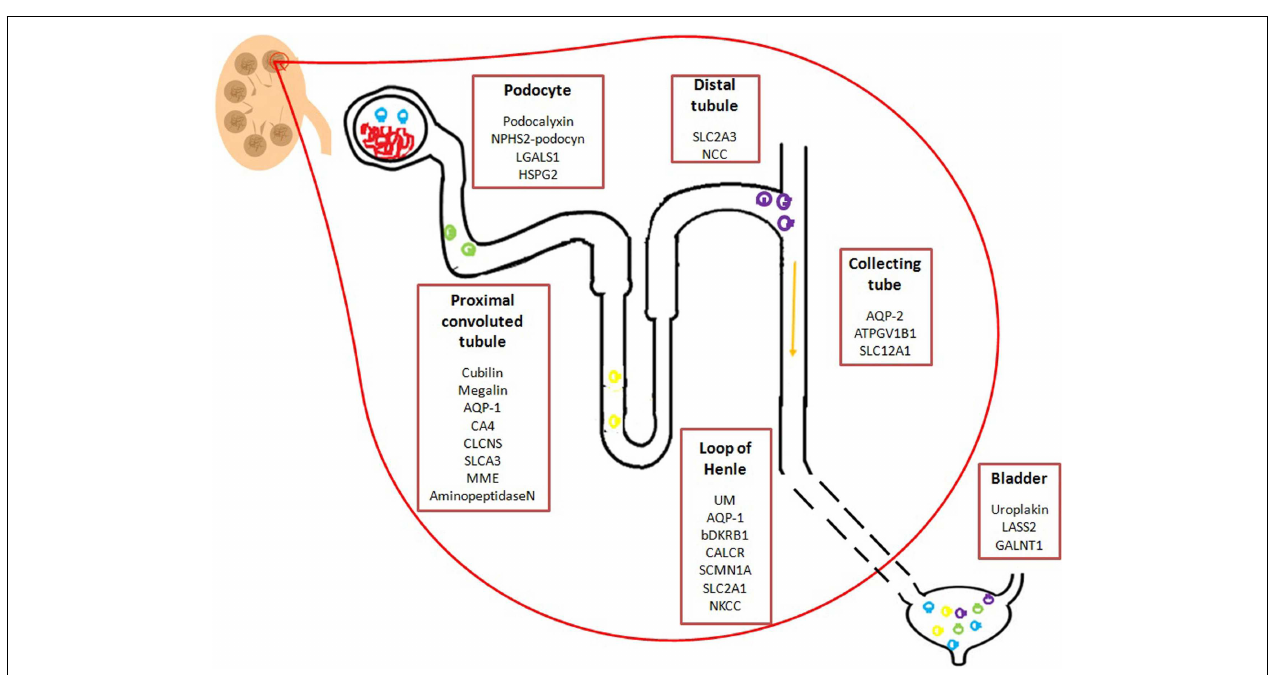
4; CLCNS: chloride channels; SLCA3: solute carrier family 3; MME: membrane metallo-endopeptidas; Loop of Henle : UM: uromodulin; bDKRB1: bradykinin receptor B1; CALCR: calcitonin receptor; SLC2A1: solute carrier family 2; NKCC: Na + /K + /2Cl − co-transporter; Collecting tube: AQP2: aquaporin-2; ATP6V1B1:TPase, H transporting, lysosomal 56/58 kD, V1 subunit B; SLC12A1: Sodium potassium chloride co-transporter 2; Bladder: LASS2: ceramide synthase 2; GALNT1 polypeptide N-acetylgalactosaminyltransferase